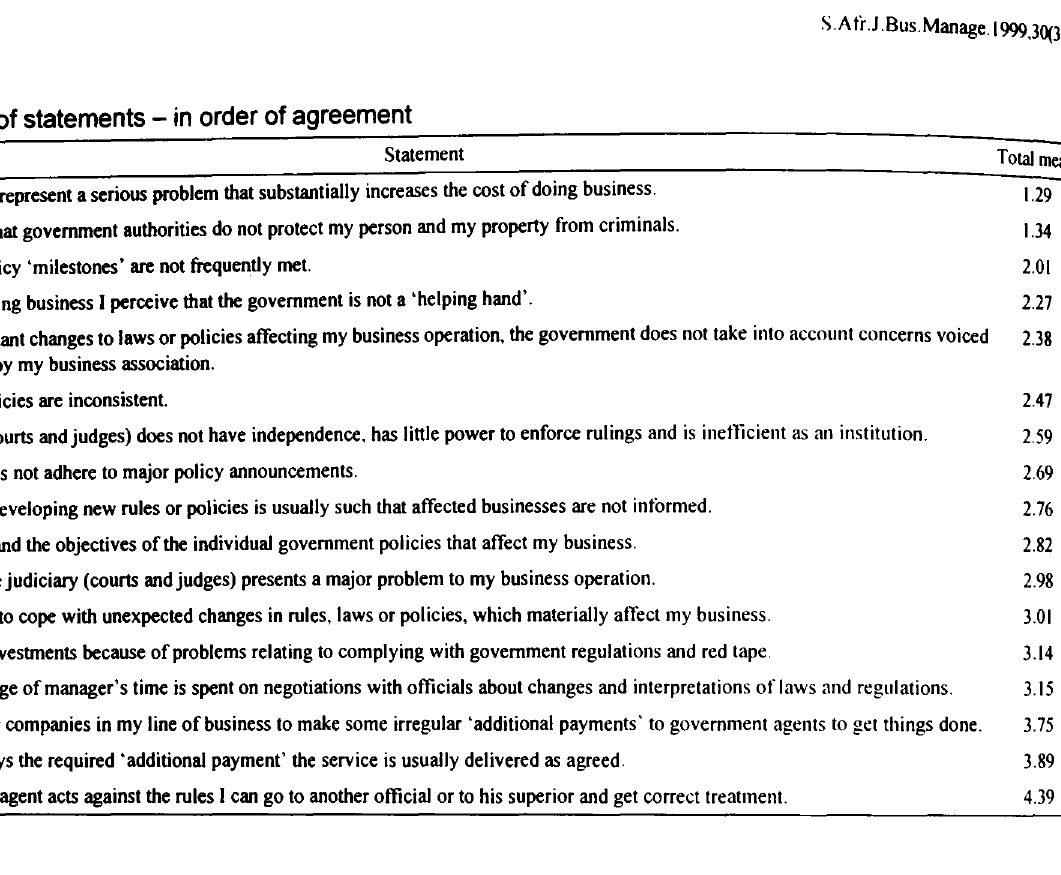
Table 4 Ranking of policy issues - in order of the extent of problems they